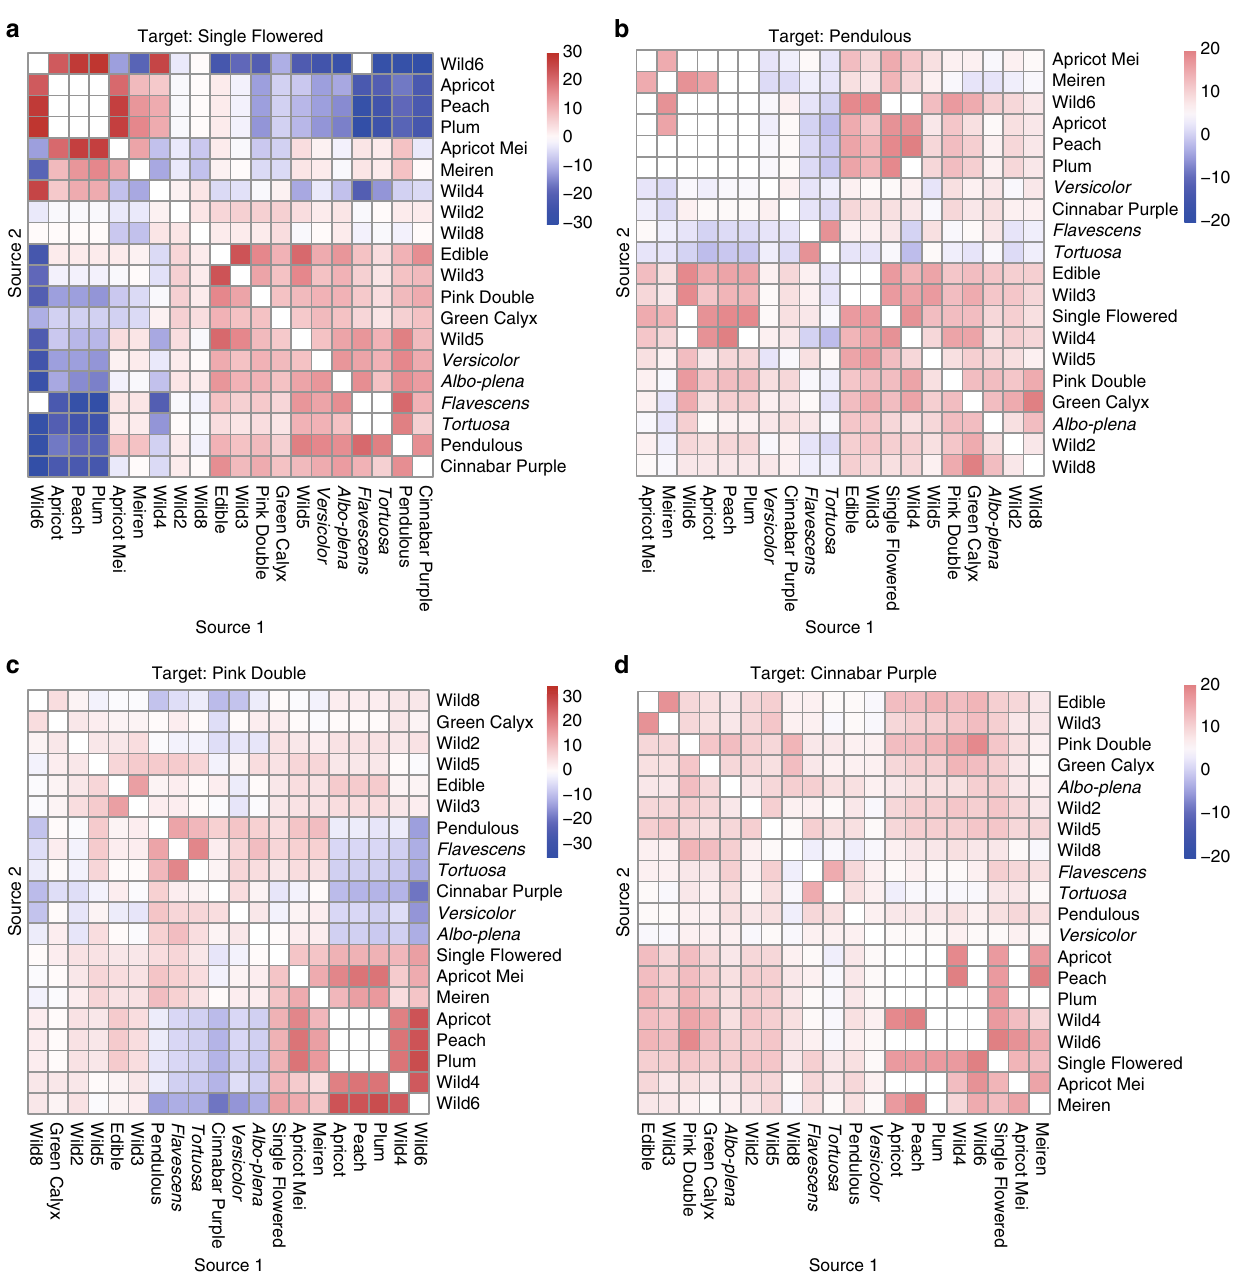
| DOI: 10.1038/s41467-018-04093-z |